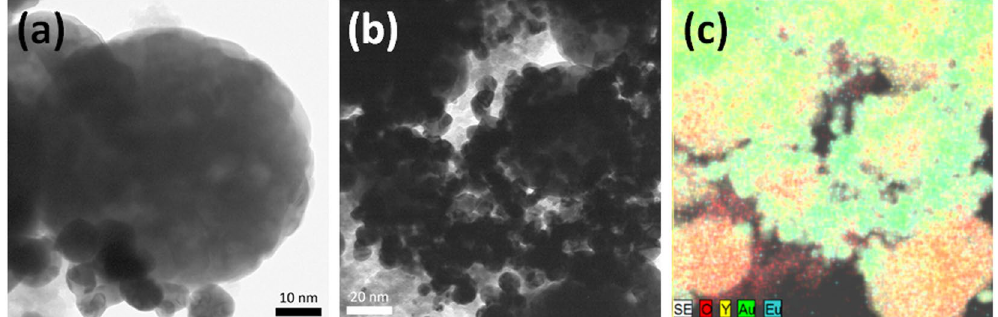
Figure 3. TEM and EDS observation of a dual functional film. Typical TEM images ( a , b ) and EDS mapping image ( c ) of phosphor monolayer on Au monolayer. EDS mapping image ( c ) is obtained from TEM image ( b